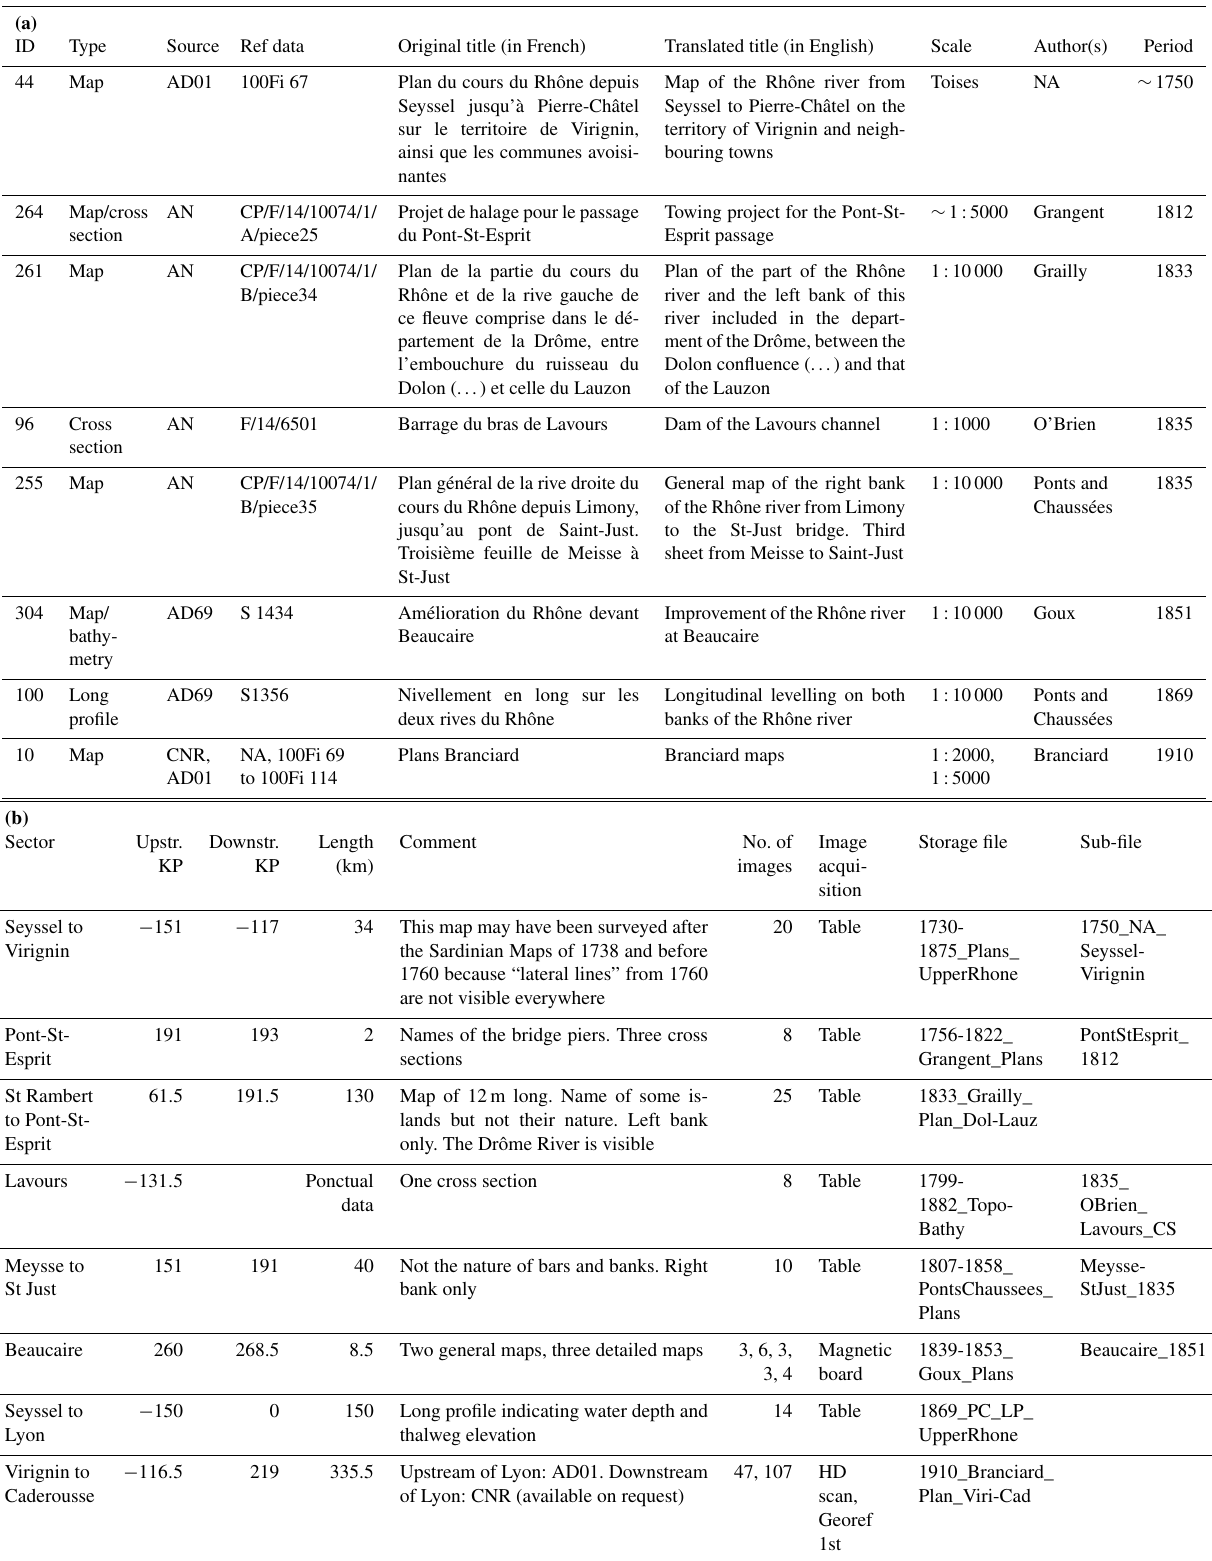
Table 1. Extract of the .csv table describing the properties of the 350 archive resources collected in this study. The symbol ∼ in the Scale column means that it was not provided in the document, and the scale was therefore estimated by direct measurement of the distance between two benchmarks or by comparison with similar